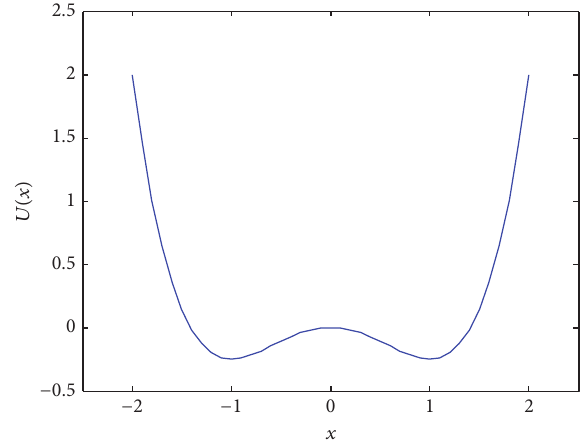
Figure 1: Potential function 𝑈(𝑥) of Duffing oscillator system.